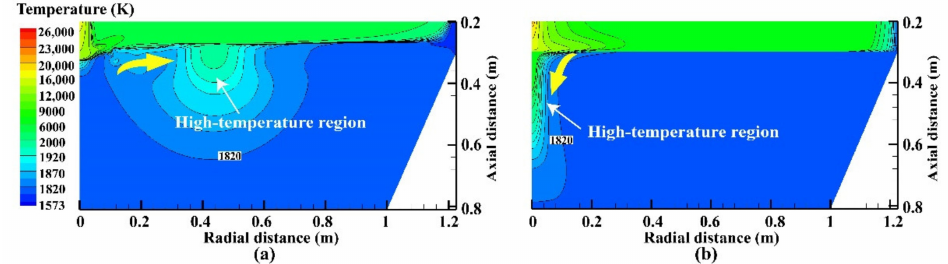
Figure 11. Temperature field in molten bath domain with an arc current of 10 kA and an arc length of 300 mm (t = 100 s): ( a ) with interface deformation; ( b ) without interface